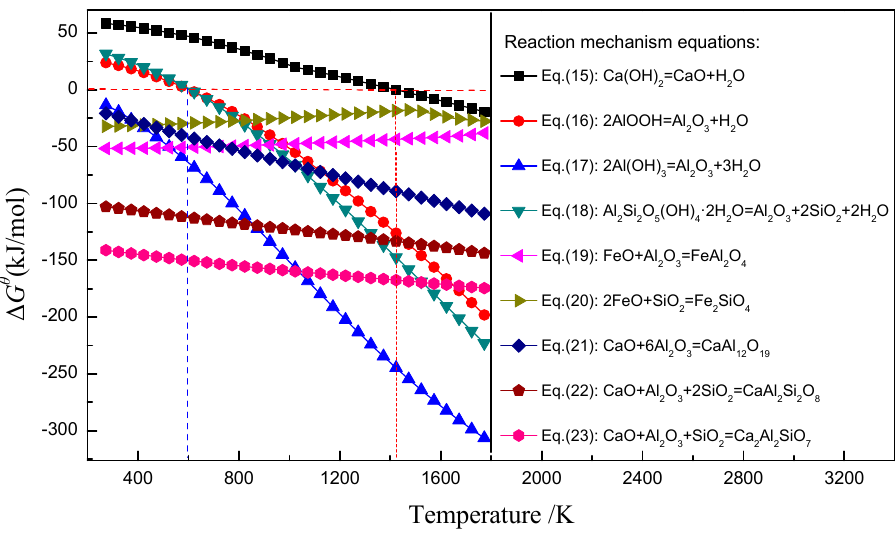
Figure 6. The standard free energy ( ∆ G θ ) with temperatures for Equations (15)–(23).